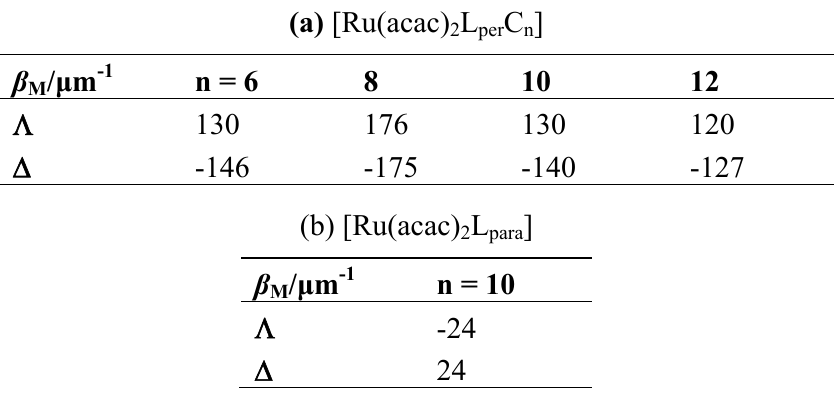
) at room temperature of [Ru(acac) M